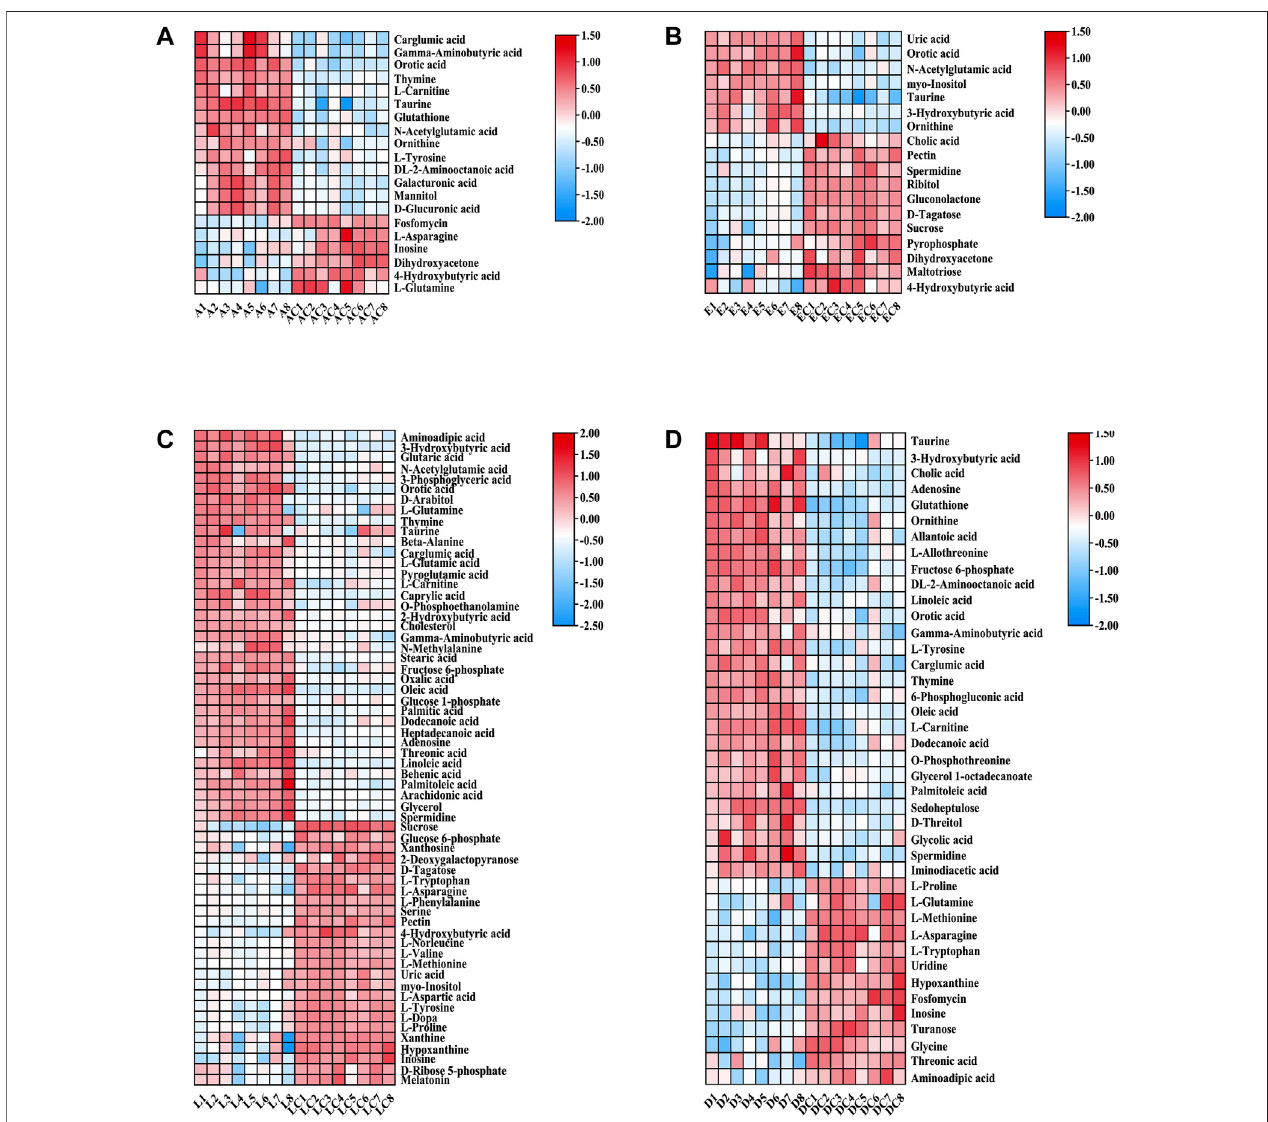
FIGURE9| HeatmapsofalteredGC-MSmetabolitesbetweenacuteintrahepaticcholestasismodelsandNCs.Colorsindicatedexpressionquantity,withblueand red representing lower and higher expression, respectively. (A) ANIT group vs. ANIT-C group. (B) EE group vs. EE-C group. (C) LCA group vs. LCA-C group. (D) DDC group vs. DDC-C